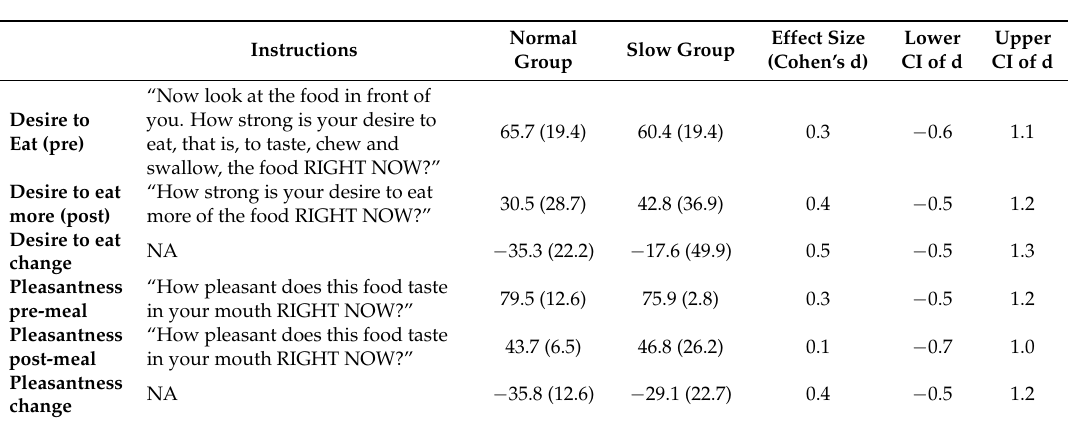
Table A2. Taste Table B2. Taste tests.